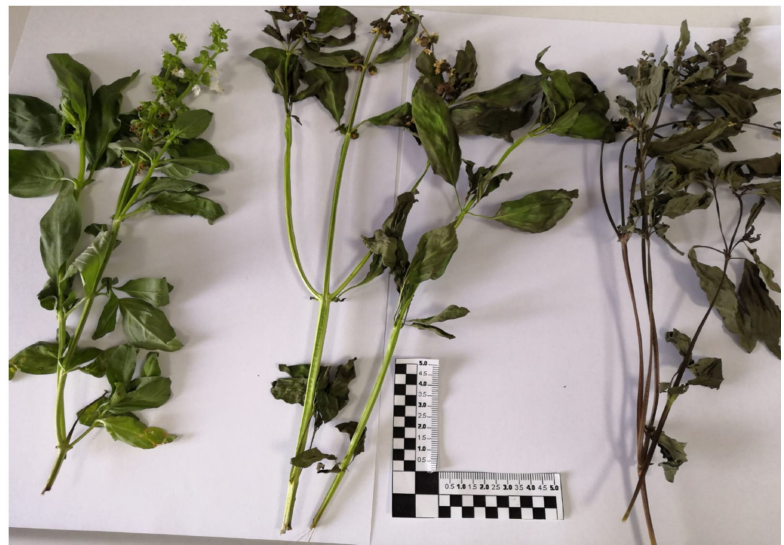
Figure 2. Comparison between microwave dried basil samples (center, MWD1) and convective method (right, CD2) and fresh basil